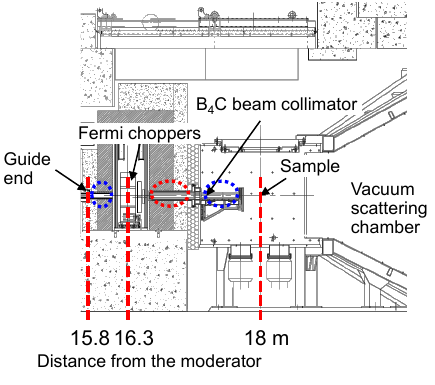
Figure 7. Cutaway view of 4SEASONS around the sample, Fermi chopper, and the end of the neutron guide. The sections marked by blue and red dotted circles are beam collimators made of B 4 C (see text for details).